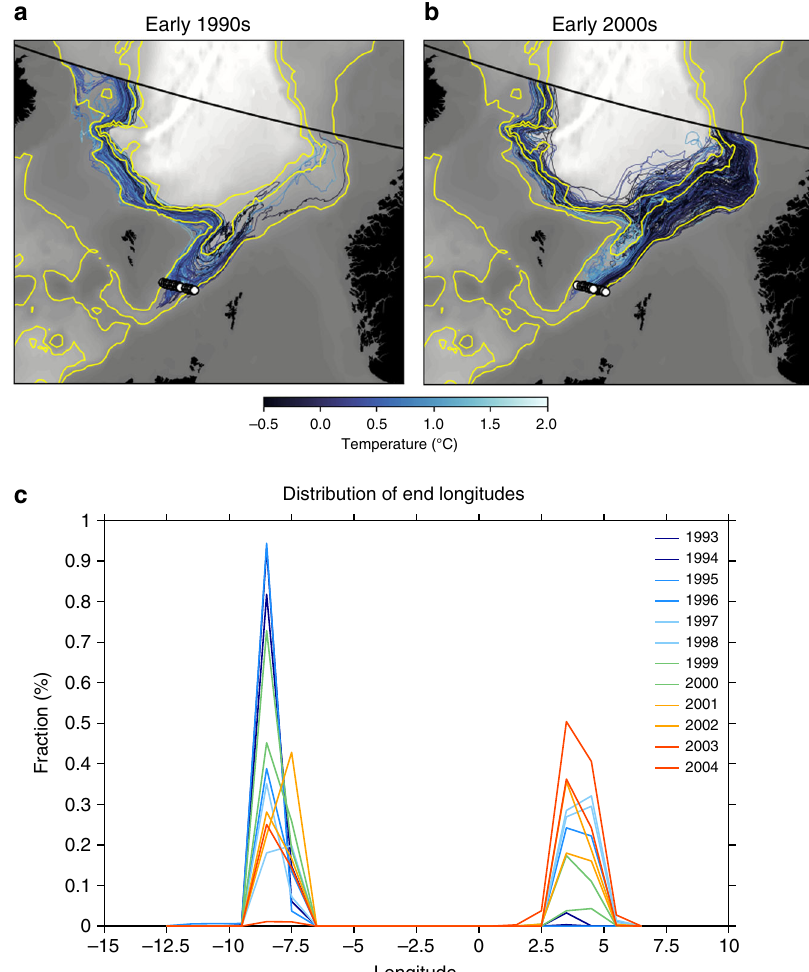
Fig. 4 Capturing the two main pathways feeding the over fl ow. a Backward trajectories released in the Faroe-Shetland Channel (FSC, white dots) in a 1994, and c 2003 and backtraced for fi ve years. The colors in both a and b indicate that only waters colder than 2 °C are traced. The yellow contours depict the 800, 1600, and 2000 m isobaths. c Probability density function of the fraction reaching the northern boundary (black line in c / d ) after one year. The blue lines represent the early 1990s period, while the red lines represent those of the early 2000s. Note, for example, during the early 1990s, most of the particles exit the domain within one year in the western part of the boundary. While during the early 2000s, particles are also seen to approach the FSC from the Norwegian slope along the eastern